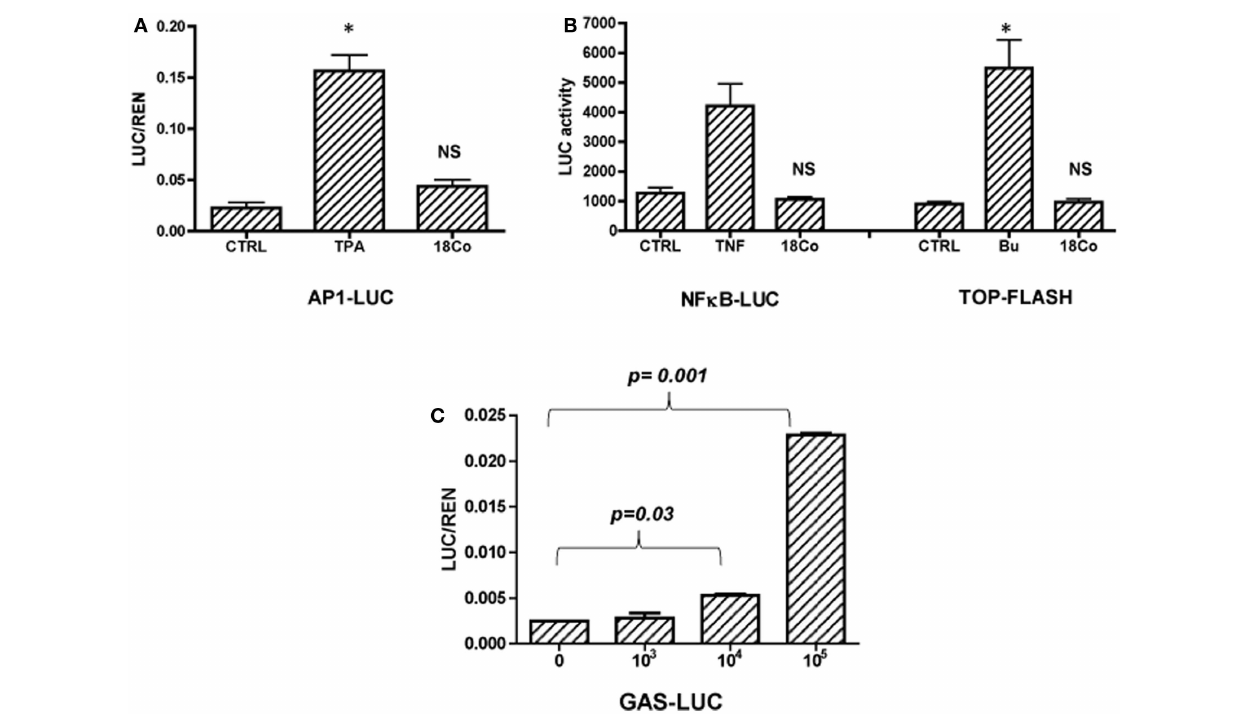
FIGURE 1 | 18Co intestinal fibroblasts induce STAT1 signaling in carcinoma cells. HCT116 cells were transfected with reported genes for AP1 (A) , NF κ B, Wnt (TOP-FLASH) (B) , or STAT1 (GAS, gamma activated sequence) and were cultured alone or in the presence of 18Co cells. (C) HCT116 cells transfected with GAS-LUC were cultured in the presence of increasing number of 18Co cells as indicated. * p = < 0.01 versus control cells; NS, non-significant.